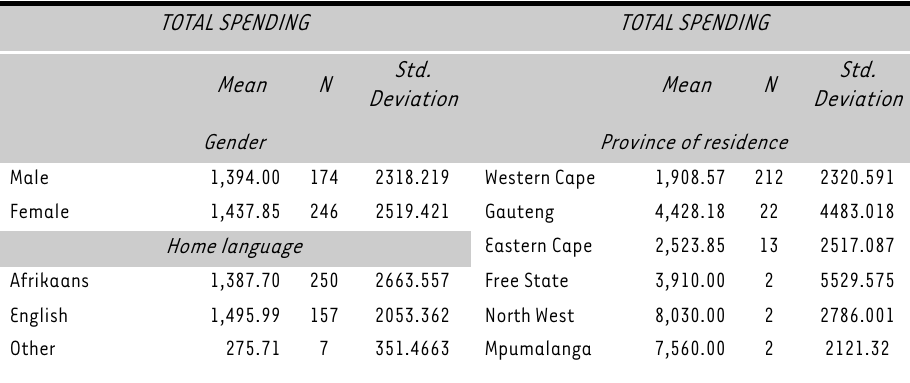
TABLE 3: Comparison of means of spending TOTAL SPENDING TOTAL